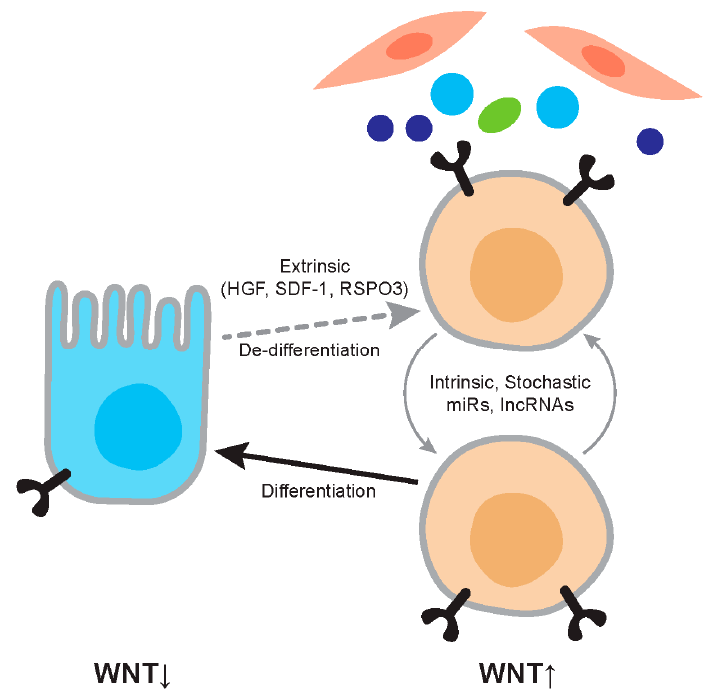
Figure 2. Regulation of Wnt activity in cancer. The figure depicts the relationship between differentiated tumor cells and cancer stem cells. Differentiated cells are relatively Wnt ‐ low and cancer stem cells relatively Wnt ‐ high. Wnt activity levels are dependent on extrinsic factors such as Hepatocyte Growth factor (HGF) and RSPO3, and on intrinsic factors such as mutation and expression levels of microRNAs (miRs). The cancer stem cell phenotype is not stable and differentiation and dedifferentiation are ongoing processes.